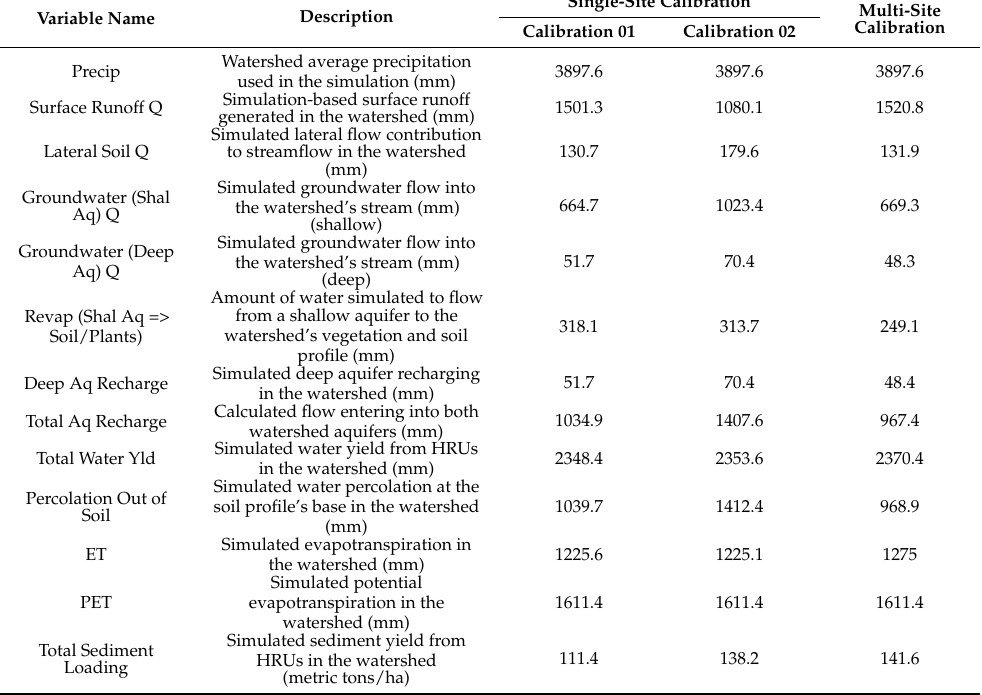
Table 10. Average annual basin values.